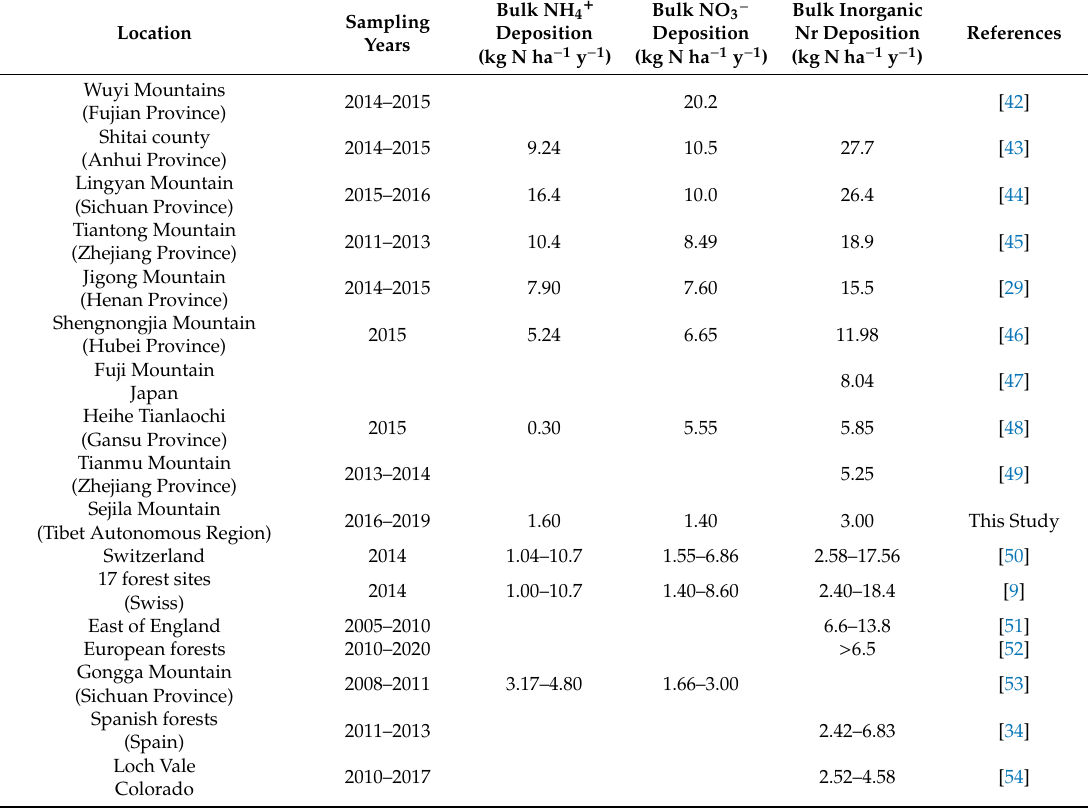
Table 1. Comparison of bulk / wet Nr deposition in a range of forest